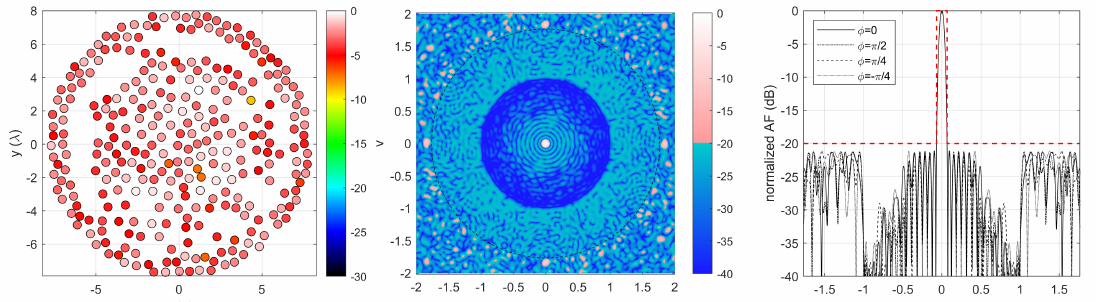
Figure 6. The 310 elements sparse layout. Left subplot: position and normalized excitation amplitude (dB) of the synthesized layout; center subplot: normalized Array Factor in the uv plane; right subplot: some relevant cuts. Negative values of w are related to the cuts φ (cid:48) = φ + π .